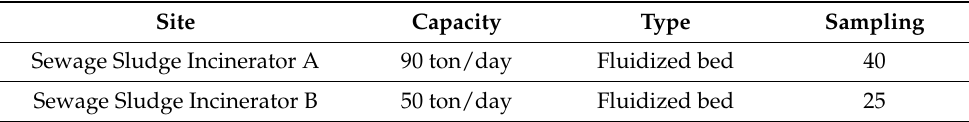
Table 1. Characteristics of the investigated sewage sludge incinerator in South